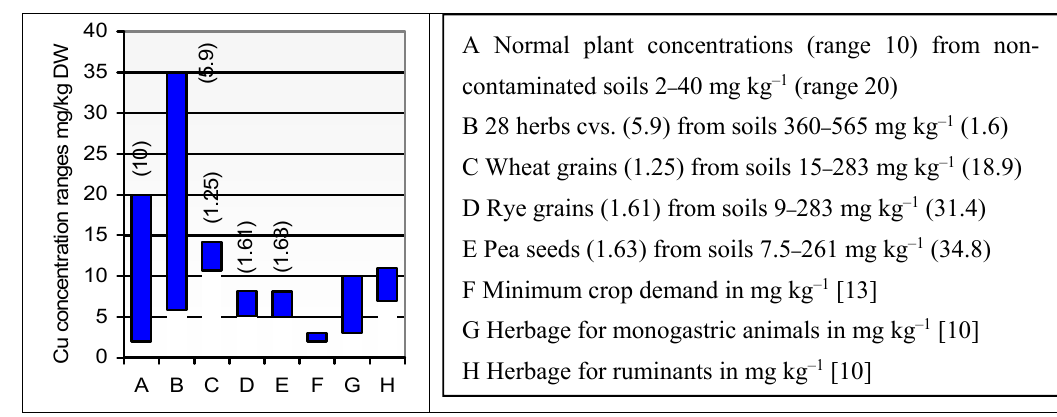
Figure 5. Normal shoot Cu concentrations of crops and rangeland plants adapted to the geochemical environment of non ‐ contaminated soils (A) rise in the presence of elevated soil Cu (B). In contrast, seeds of wheat, rye, and pea observe their adopted mineral target stock by compensating for widest soil mineral fluctuations with proportionate seed:soil TF adaptations (C–E). Their mineral content surpasses the putative minimum crop demand (F) but concurs exactly with pretensions to the forage for herbivores (G, H). ( ), concentration spans. Refer to Table 4 for the ecological position of further nutritionally relevant elements. Adapted from primary data of Gramss and Voigt [18,27].